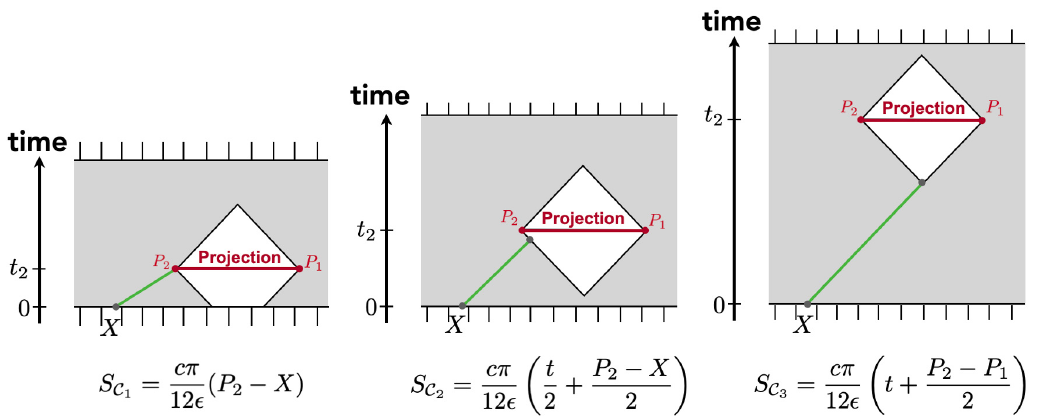
Figure 8 . Three configurations in line-tension